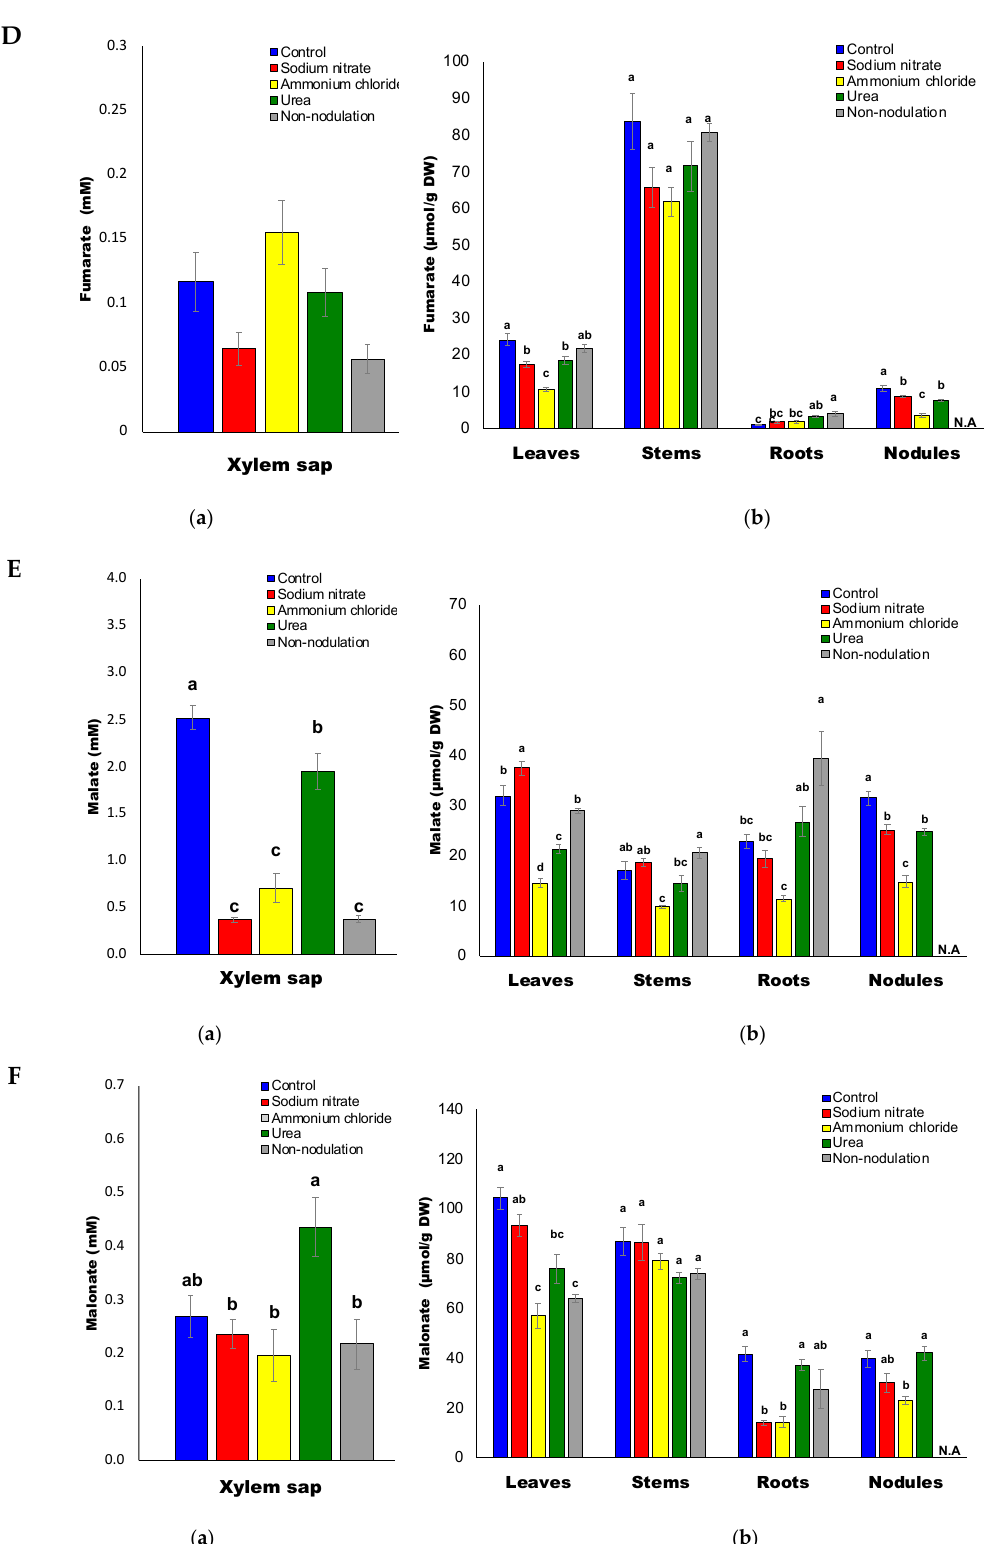
Figure 7. ( A ) Citrate concentrations in the xylem sap ( a ) and in each part ( b ) of the soybean plant. (B). α -Ketoglutarate concentrations in the xylem sap ( a ) and in each part ( b ) of the soybean plant. ( C ) Succinate concentrations in the xylem sap ( a ) and in each part ( b ) of the soybean plant. ( D ) Fumarate concentrations in the xylem sap ( a ) and in each part ( b ) of the soybean plant. ( E ) Malate concentrations in the xylem sap ( a ) and in each part ( b ) of the soybean plant. ( F ) Malonate concentrations in the xylem sap ( a ) and in each part ( b ) of the soybean plant. N.A: not available.